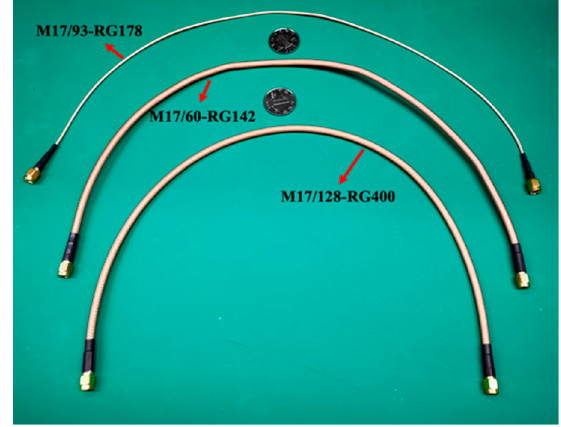
Figure 6. The di ff erent types of coaxial cables (0.5 m) used in our Figure 6. The different types of coaxial cables (0.5 m) used in our experiment.